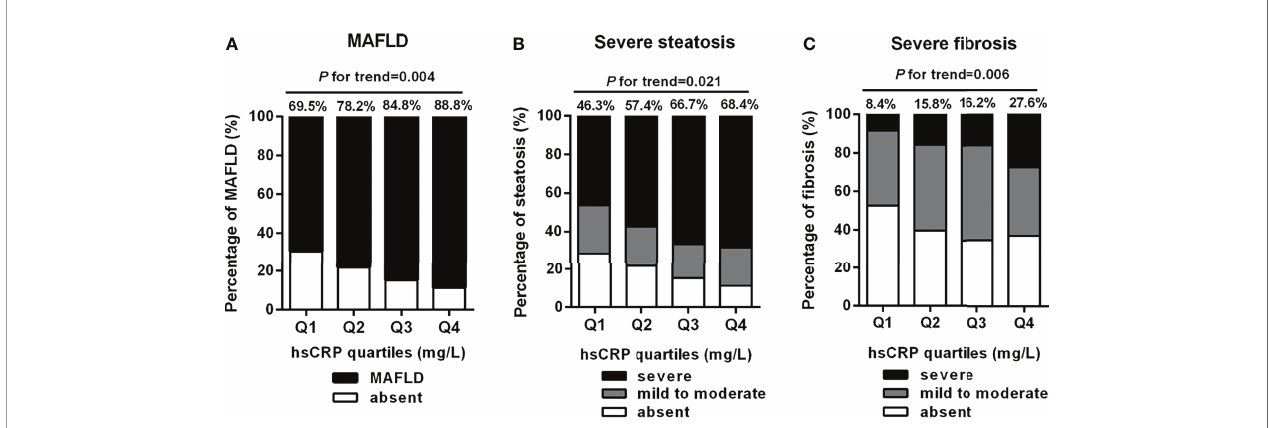
FIGURE 2 | Percentage of MAFLD, severe steatosis, and severe fi brosis across serum hsCRP quartiles in obese patients. Serum hsCRP levels were plotted into four quartiles (Q1, Q2, Q3, and Q4). There was a signi fi cantly increasing trend in the percentage of MAFLD (A) , severe steatosis (B) , and severe fi brosis (C) across serum hsCRP quartiles ( P -trend = 0.004, 0.021, and 0.006, respectively). P -values < 0.05 were accepted as statistically signi fi